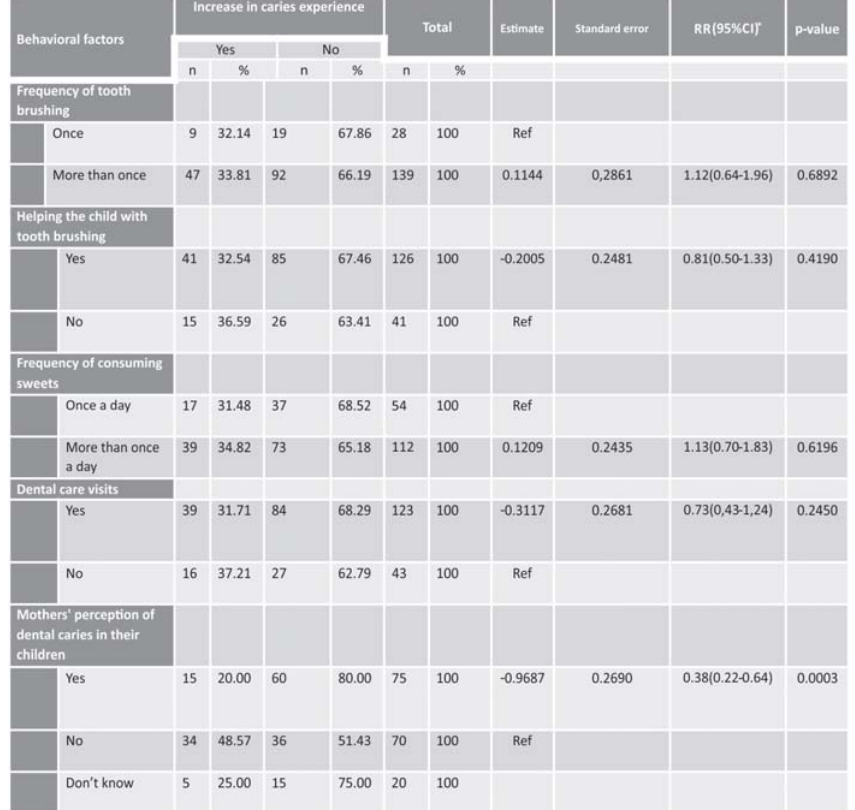
Table 2. Association between children’s and parent’s oral health-related behaviors and incidence of dental caries.